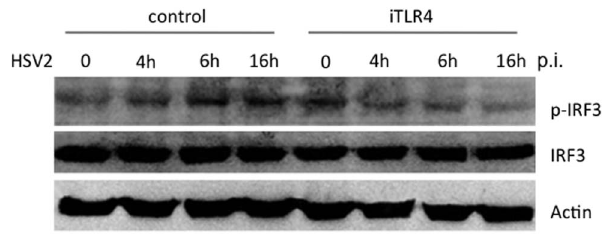
Figure 2. TLR4 mediates the phosphorylation of IRF3 in response to HSV-2. HCE cells were transfected with scrambled shRNA control or iTLR4. Forty-eight hours after transfection, cells were infected with HSV-2 at 3 MOI or mock-infected. Cell lysates were collected at 0 h, 4 h, 6 h, 16 h post-infection and analyzed by Western blotting with antibodies against p-IRF3, total IRF3 and Actin. Knockdown of TLR4 decreased the phosphorylation of IRF3 by HSV2 infection. The experiment was repeated three times, the representative